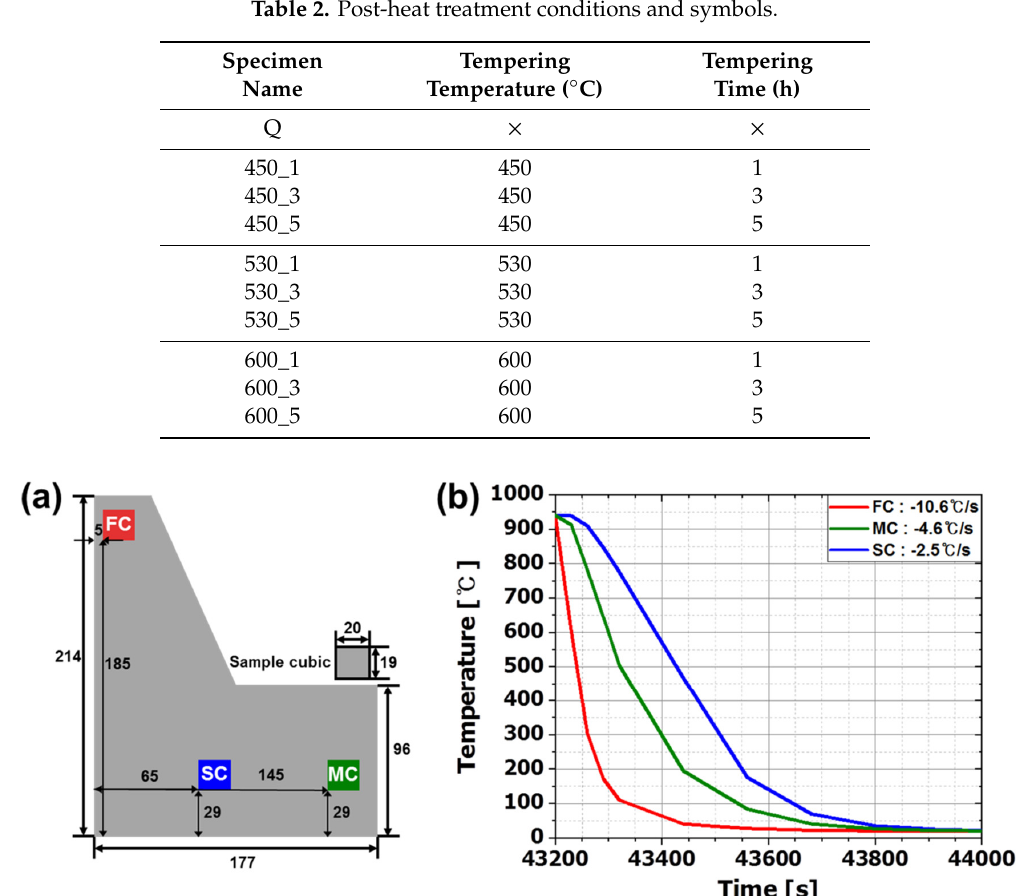
Figure 2. ( a ) Schematic illustration of each specimen location according to CR. Dimensions: mm. ( b ) Cooling curve of each specimen obtained by FEM simulation (Forge NxT 3.0). Colors in ( a ) location and ( b ) cooling curves indicate cooling rates; red, green and blue mean FC ( − 10.6 ◦ C / s), MC ( − 4.6 ◦ C / s) and SC ( − 2.5 ◦ C / s) respectively.